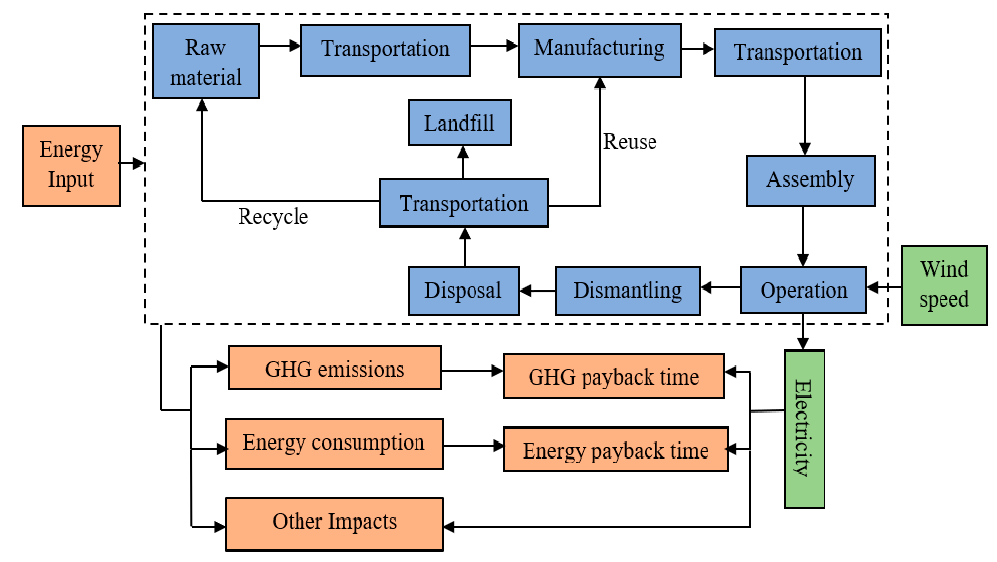
Figure 2. LCA system boundary and impact assessments. The dashed box contains the life cycle components.